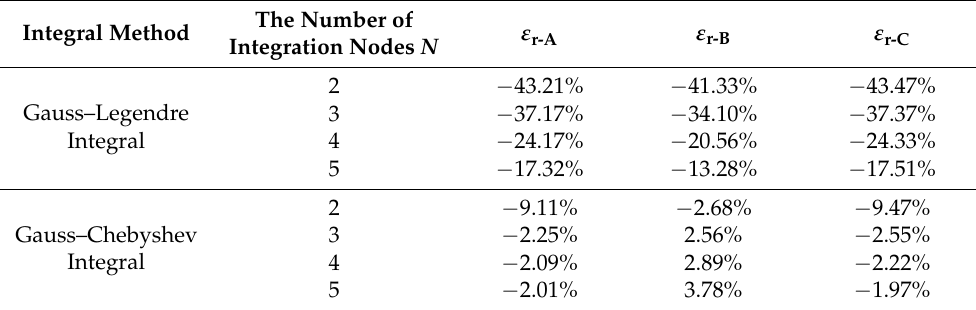
Table 1. The relative error of inversion voltage’s amplitude with different numerical integration methods and numbers of nodes.